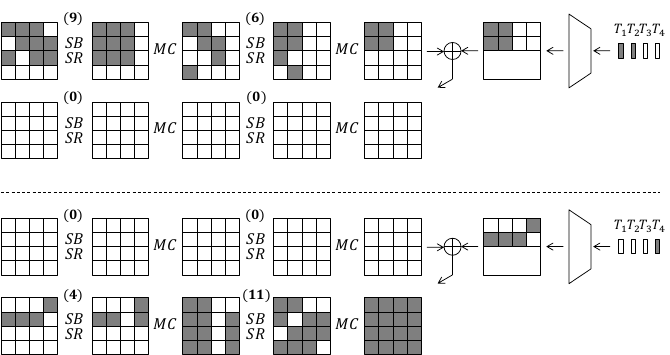
Figure 1: 4-round Core of TweAES [ ∗ , ∗ , ∗ ,2]